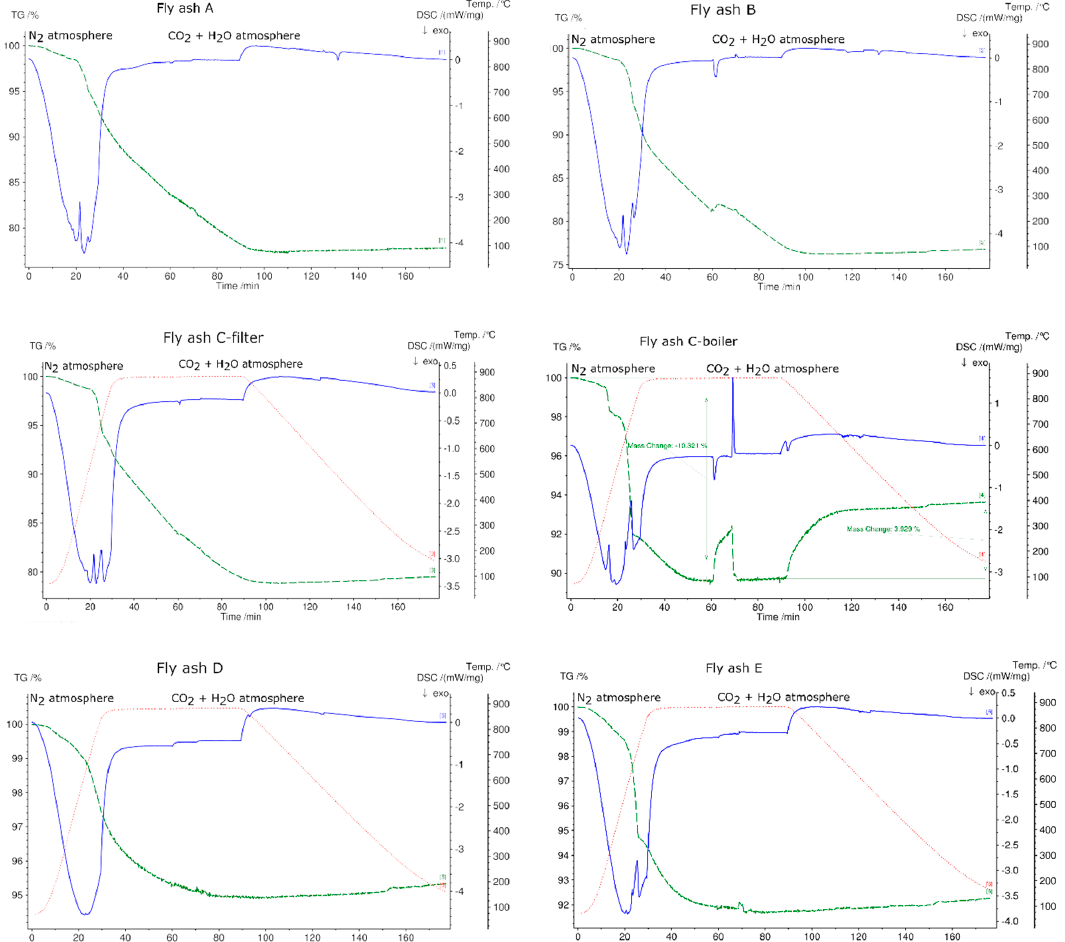
Figure 10. Charging and discharging of fly ash samples in STA. Charging at a heating rate of 30 ◦ C / min to 880 ◦ C in N 2 atmosphere and discharging of fly ash samples in pure CO 2 (100 ml / min) with added water vapor H 2 O (1 g / h) at a cooling rate of 10 ◦ C / min. Green line denotes the percentage of mass loss, blue line denotes DSC signal, and dotted red line denotes temperature profile.